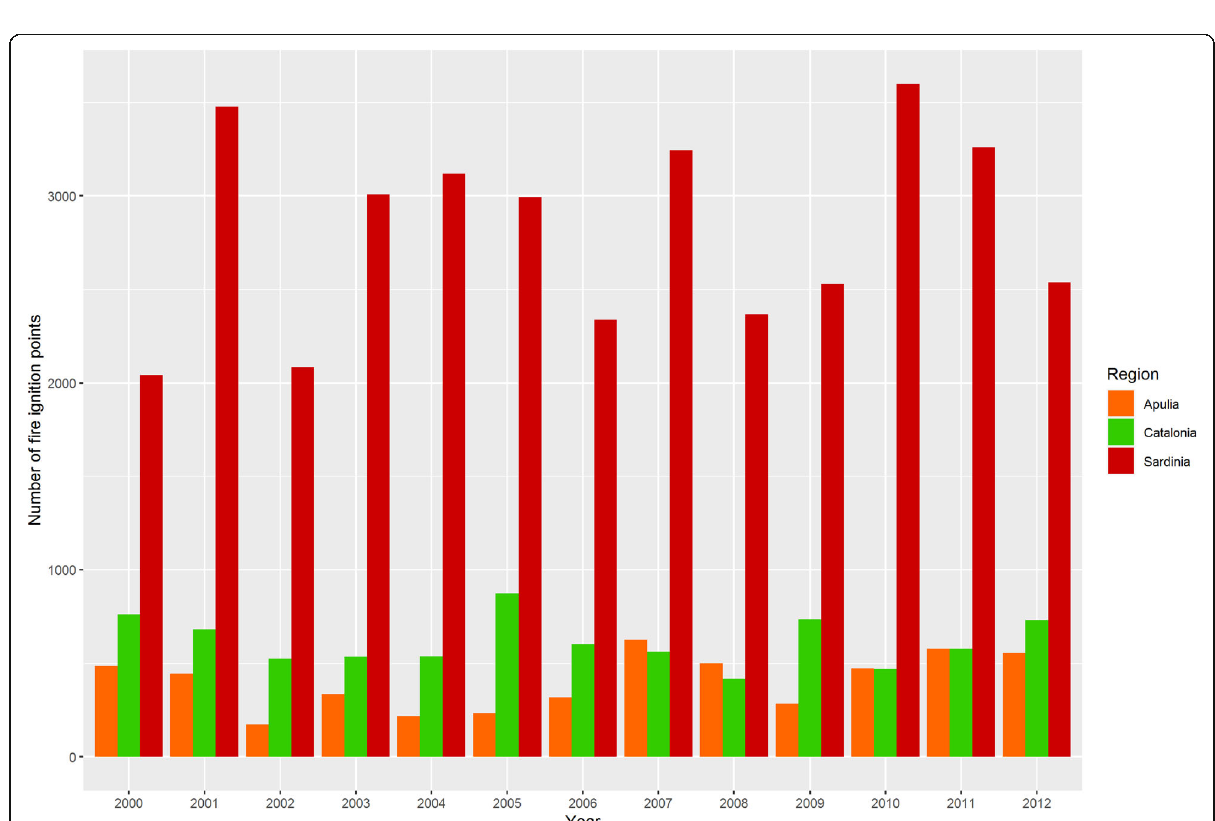
Fig. 2 Distribution of fire ignition points in Catalonia, Sardinia, and Apulia during the 2000 – 2012 time